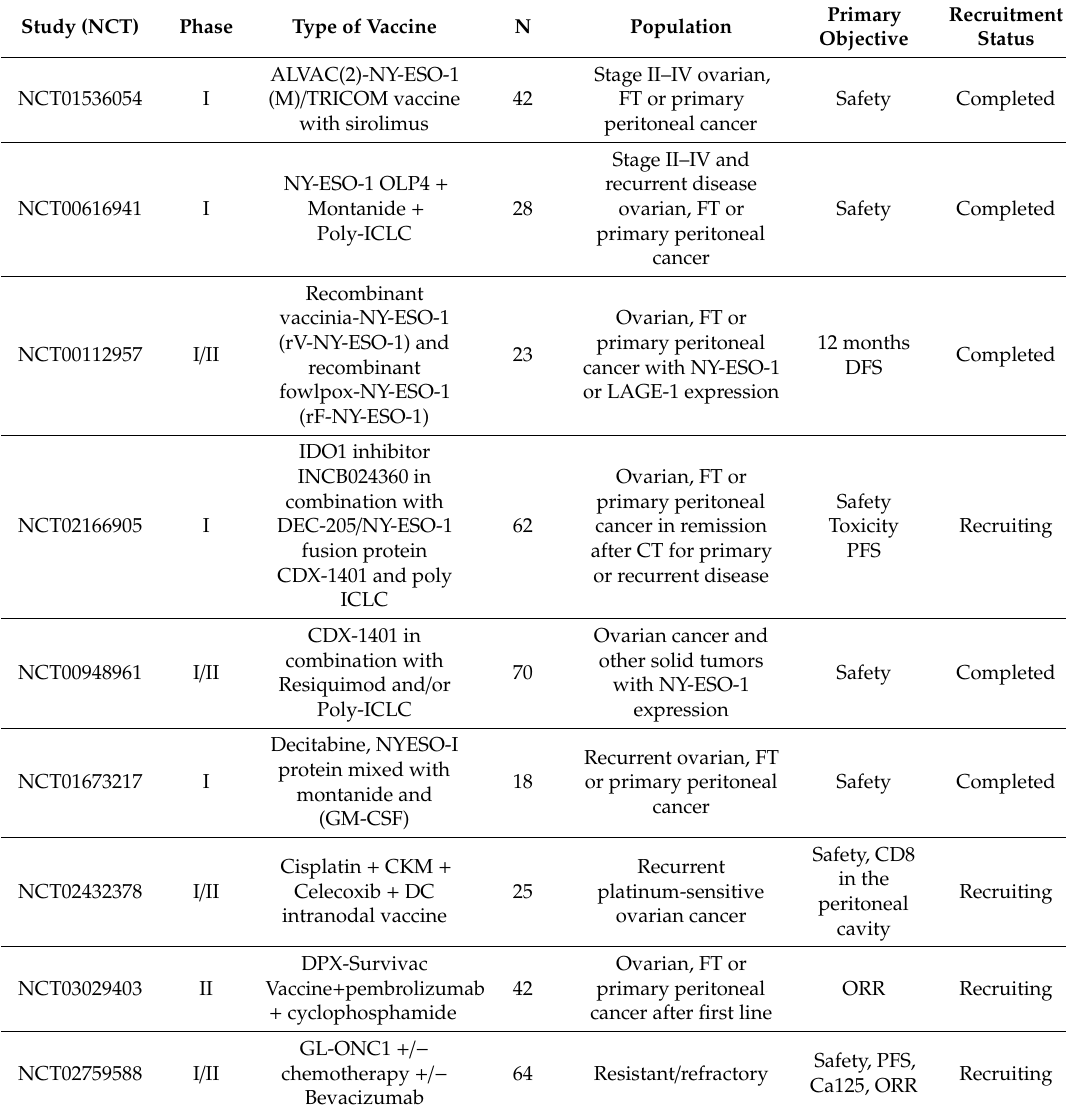
Table 3. Selected ongoing vaccination